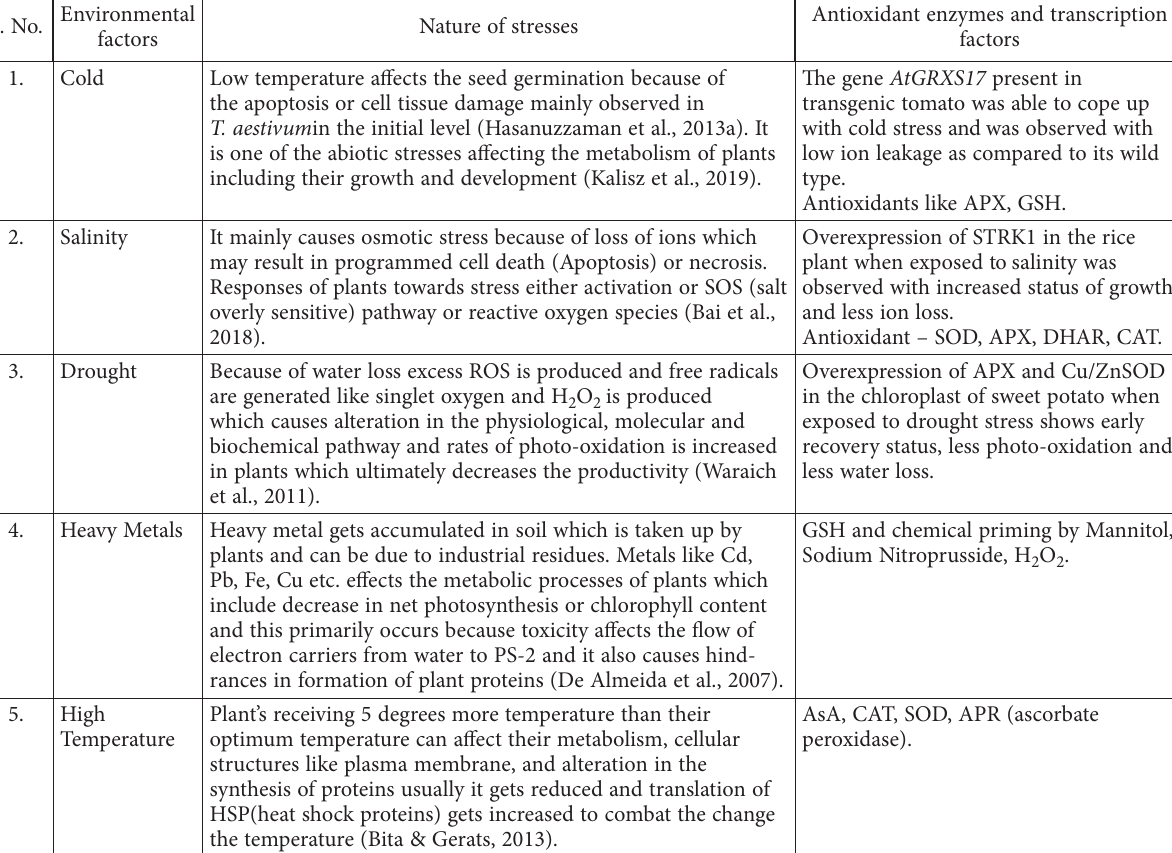
Table 1. Factors affecting the oxidative